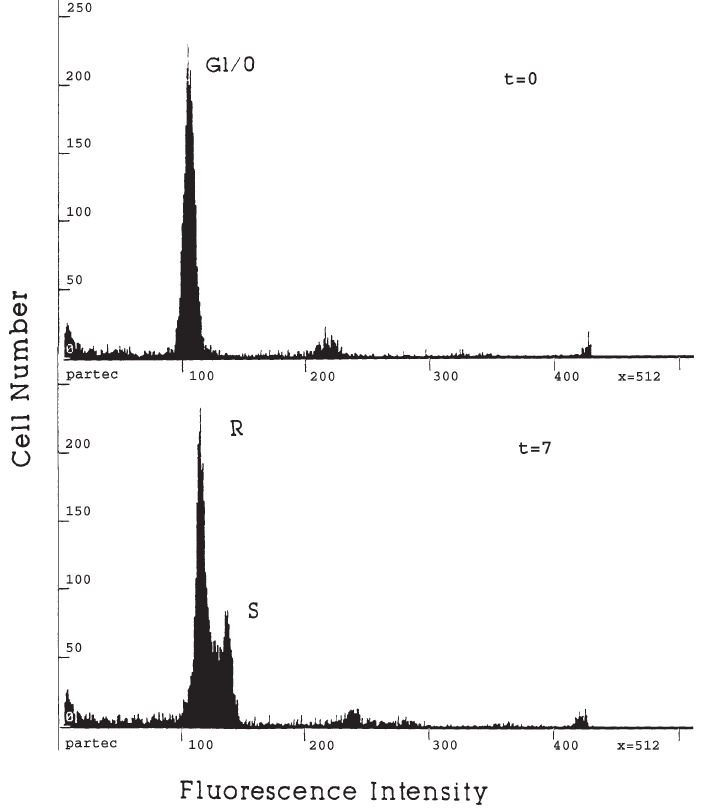
Fig. 6. Identification of cells sensitive (S) and resistant (R) to increase in fluorescence intensity (IFI) induced by heparin, illustrated by two consecutively recorded DNA patterns in a colorectal adenoma. The percentages of resistant and sensitive cells amount to 60% and 40%. Sensitivity is related to condensed chromatin of transcriptionally inactive cells, resistance to dispersed chromatin of transcriptionally active